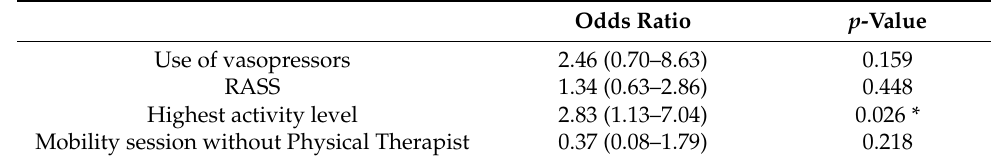
Table 4. Risk factors for the occurrence of patient-related safety events. Odds Ratio